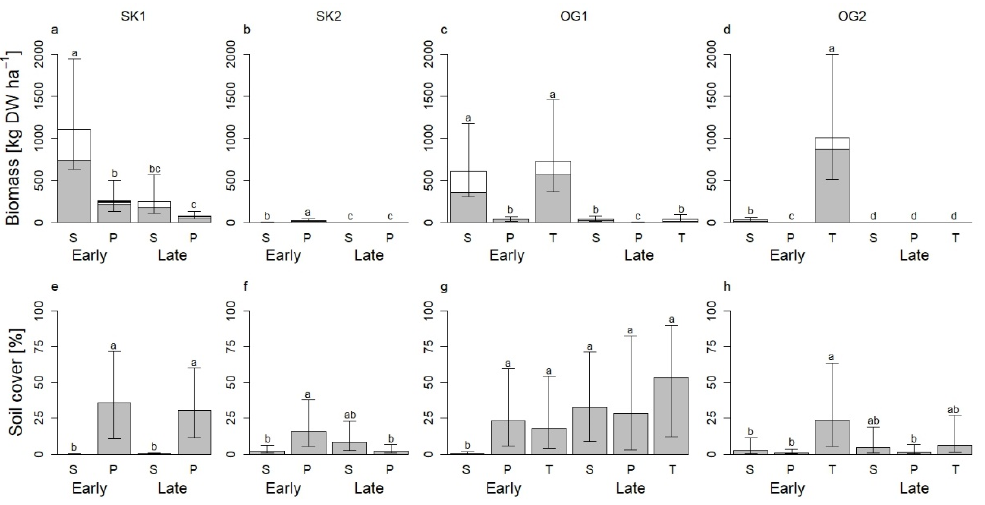
Figure 4. Service crop biomass before oat harvest ( a – d ) and soil cover in autumn ( e – h ) at the four experimental sites. Abbreviations: SK and OG stands for the two experimental regions, 1 = starting 2017, 2 = starting 2018, C = no service crop, S = frost-sensitive annuals, P = perennials, T = frost- tolerant annuals. Biomass values are back-transformed from log-transformed model estimates. In biomass plots the grey scale indicates the species in the mixtures: gray = Trifolium squarrosum (S), T. pratense (P) and Vicia villosa (T), white = T. resupinatum (S), T. repens (P), and T. incarnatum (T), black = Medicago lupulina (P). Early and Late indicate system strategy. See Materials and Methods and Table 1 for detailed information. Error bars indicate the 95% confidence interval for the total biomass and soil cover, respectively. The letters indicate significant differences between treatments within each experiment.